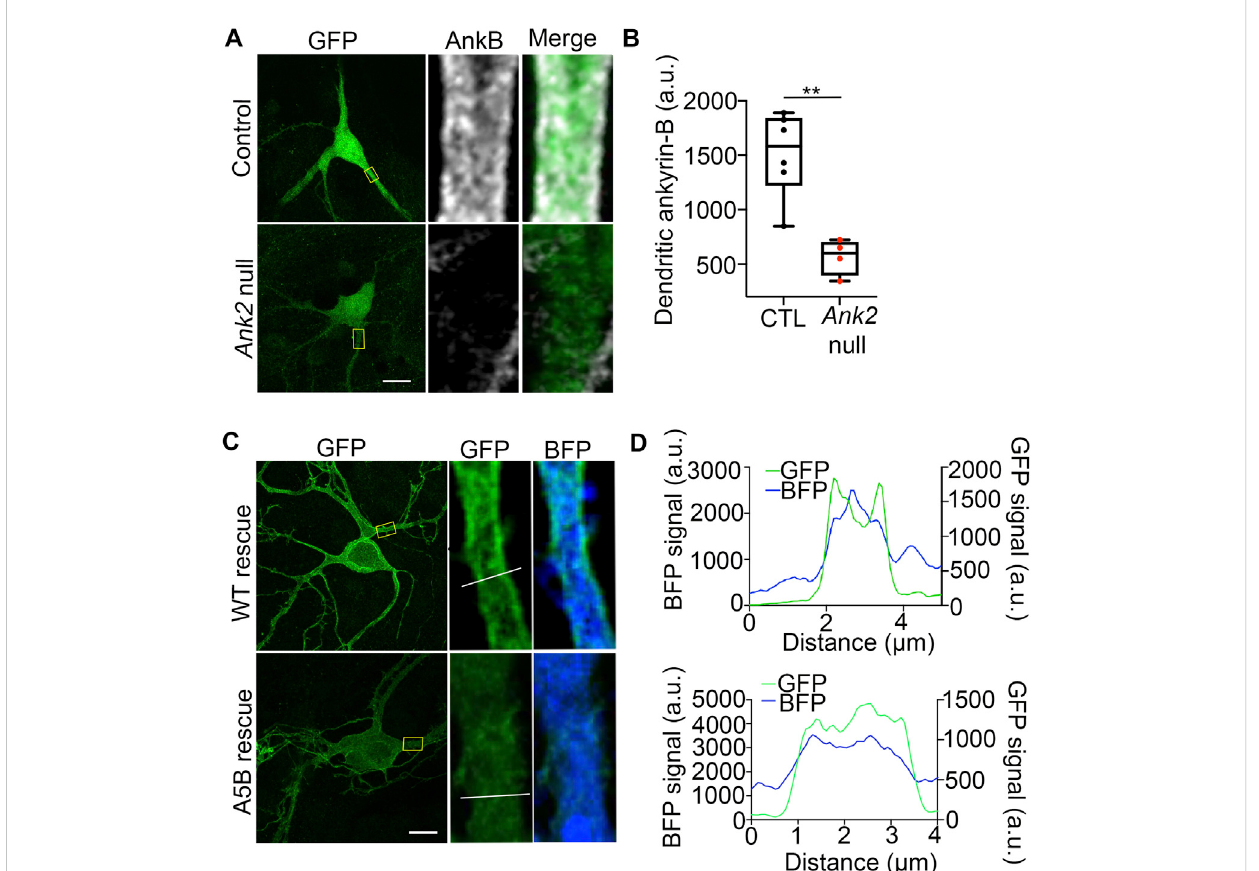
FIGURE 7 Palmitoylation-dead ankyrin-B is unable to target to dendritic membranes in neocortical pyramidal neurons. (A) . Representative collapsed Z -stack ( left ) and zoomed-in single stack images ( right ) of DIV21 cultured fl oxed Ank2 cortical neurons transfected at DIV2 with soluble GFP and BFP ( top ) or solubleGFPandCre-2A-BFP( bottom )toknock-outankyrin-B.Boxesdenotezoomed-insectionofthedendrite.Scalebars20 µm.Neuronsstainedwith anti-GFPshowningreenandanti-ankyrin-Bshowninfarred.Note:residualankyrin-Bimmunoreactivityisduetonearbyuntransfected fl oxed Ank2 neurons, which are Cre -negative, and thus still express ankyrin-B. (B) . Quanti fi cation of mean fl uorescence intensity of dendritic ankyrin-B from (A) . P** < 0.01 relative to Control; student ’ s t-test (unpaired), N = 4-6 neurons for each group across three independent replicates. (C) . Representative collapsed Z -stack ( left ) and zoomed-in single stack images ( right ) of DIV21 cultured fl oxed Ank2 cortical neurons transfected at DIV2 both transfected with Cre-2A-BFP to knock-out ankyrin-B and either rescued with WT ankyrin-B-GFP ( top ) palmitoylation-dead AAAAA-ankyrin-B-GFP ( bottom ) to assess dendritic membrane localization of ankyrin-B. Yellow boxes denote zoomed-in section of the dendrite. White line denotes region of interest across the dendrite used to generate plot pro fi les outlining membrane versus cytoplasmic ankyrin-B-GFP staining. Scale bars 20 µm. Neurons stained with anti-GFP shown in green. Blue fl uorescence comes from the BFP downstream of the 2A peptide, which fi lls the cell as soluble BFP. (D) . Plot pro fi le outlining membrane versus cytoplasmic GFP (ankyrin-B) (green) and BFP (blue) staining across dendrite (region of interest denoted by white line on zoomed-in single stack). What appears as plasma-membrane localization of ankyrin-B at dendrites is demonstrated by the two green peaks fl anking the solubleBFPpeak.Thetwogreenpeaksinplotpro fi